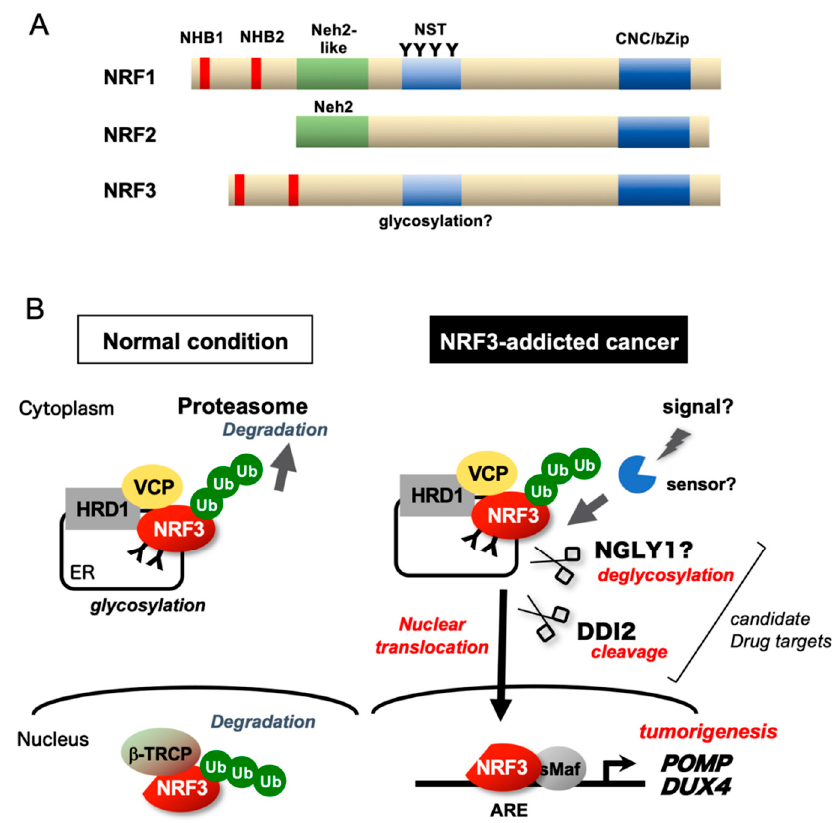
Figure 5. Regulatory mechanisms of NRF3. ( A ) Schematic structures of NRF1, NRF2, and NRF3. ( B ) Under physiological conditions, the transcriptional activity of NRF3 is suppressed by NRF3 sequestration in the endoplasmic reticulum (ER) via the N-terminal homology box 1 (NHB1) domain and HRD1-mediated proteasomal degradation. In NRF3-addicted cancer, NRF3 is liberated from multiple suppression mechanisms and processed at the NHB2 domain by the DNA damage-inducible 1 homolog 2 (DDI2) protease, thereby activating gene expression in the nucleus. Cap ‘n’ collar (CNC)-bZip, CNC-basic leucine zipper; β -TRCP, β -transducin repeat containing E3 ubiquitin protein ligase; ARE, antioxidant-response element; NST, Asn / Ser / Thr-rich; NHB, N-terminal homology box; sMaf, small Maf; Ub, ubiquitin; and VCP, valosin-containing protein.